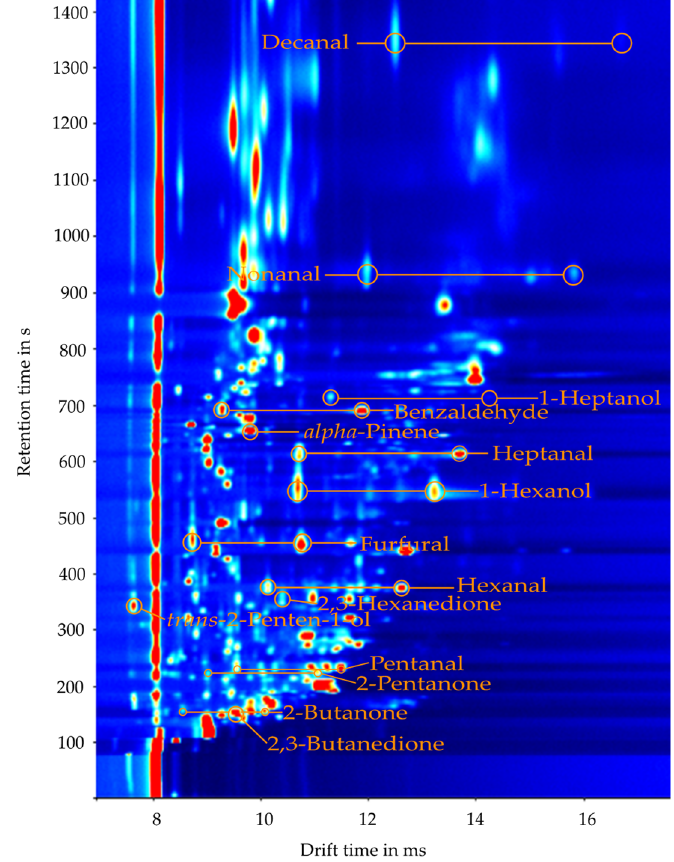
Figure 6. Partial GCxIMS plot of a store-bought linden-type honey with the identified monomer and dimer signals labeled. Table 1. Retention times and reduced ion mobility (K 0 ) for the monomers and dimers of the identified substances, including the CAS numbers.